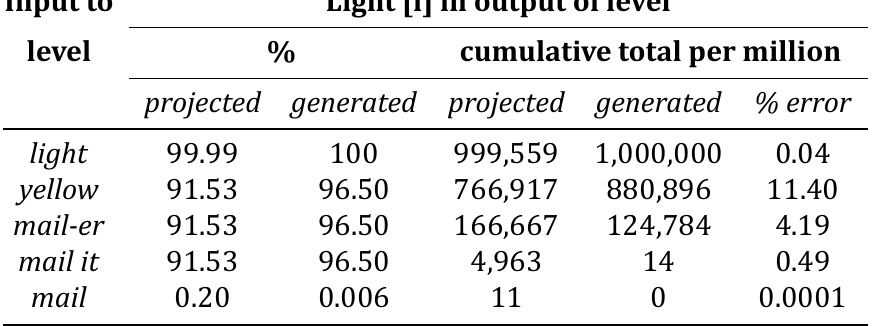
Table 15: Phrase level